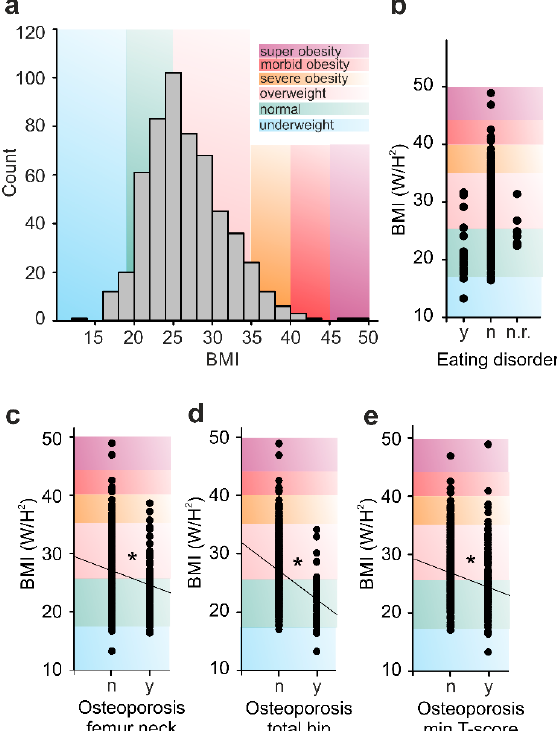
Figure 3. Correlation of the body mass index (BMI) with osteoporosis (OP). ( a ) Histogram of the BMI showing a right-skewed distribution, with more than 50% of the sample being overweight to morbidly obese. ( b ) A scatterplot showing how the BMI correlates with eating disorders (ED), yes = y, no = n, n.r. = no response. The BMI of patients with an ED was lower than that of patients without ED, however, all were not necessarily underweight, p < 0.05 Spearman’s correlation. ( c – e ) BMI correlation with the OP in ( c ) the femur neck r s − 0.177, (d) total hip r s − 0.273, and ( e ) based on the minimum T-score r s − 0.197. Regardless of the measuring site, patients with OP had a lower BMI than that of non-OP patients, p < 0.001 Spearman’s correlation. The correlation coefficient of Spearman (r s ) is indicated by a solid diagonal line. Statistically significance at p < 0.05 is denoted with an asterisk.